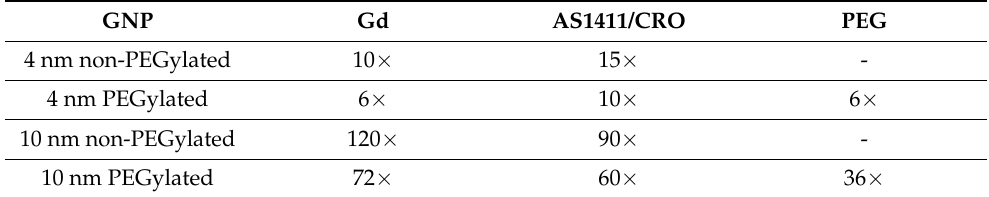
Table 1. Demonstration of the concentration amounts of functionalizing